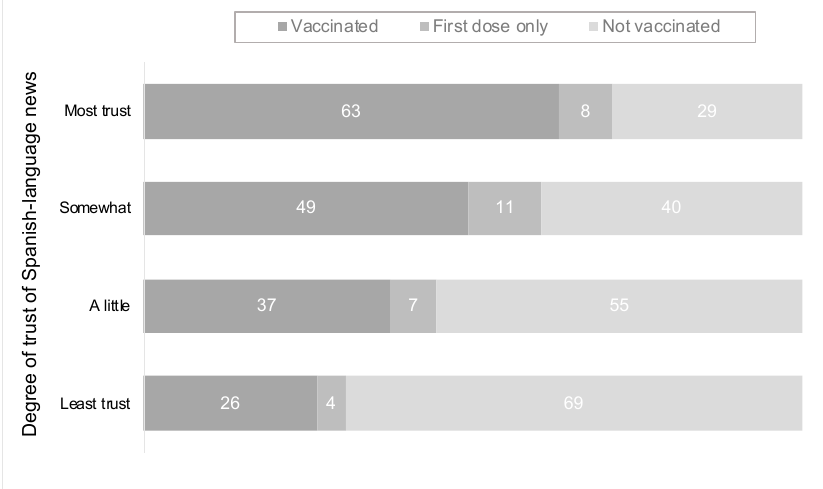
Figure 6. Covid-19 vaccination rates among Latino adults by trust in Spanish-language news (June 2021). Source: American COVID-19 Vaccine Poll. Notes: results presented in percentages from the